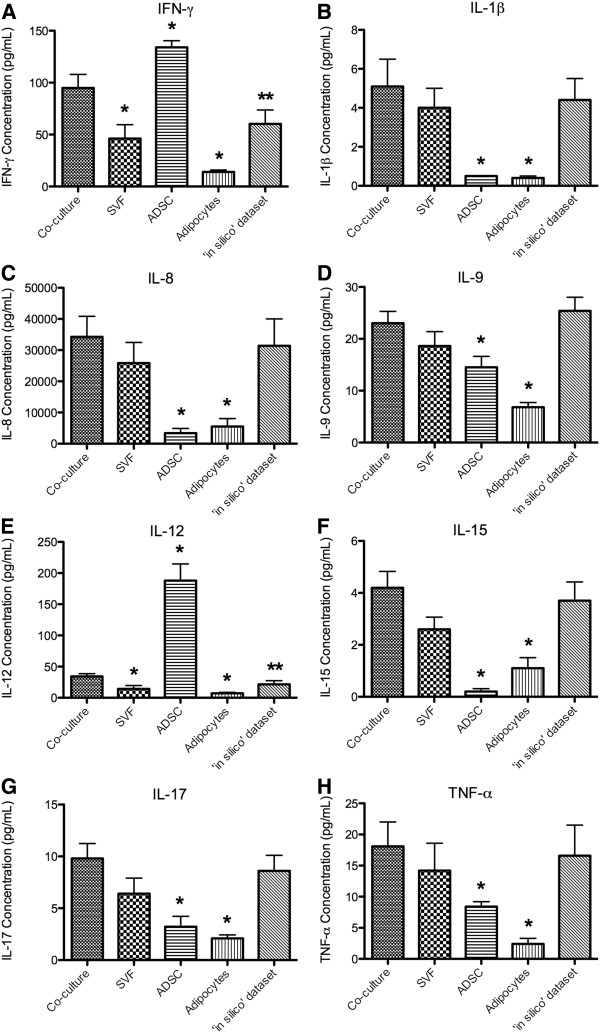
Average concentration of pro-inflammatory cytokines secreted by adipose-derived cell populations. The concentrations of the pro-inflammatory cytokines, IFN-γ (A), IL-1β (B), IL-8 (C), IL-9 (D), IL-12 (E), IL-15 (F), IL-17 (G) and TNF-α (H) were measured in the conditioned medium of the stromal vascular fraction (SVF) co-cultured with adipocytes (co-culture), SVF, adipose-derived stem cells (ADSC), and adipocytes, as well as the ‘in silico’ dataset. The reported values are the average of 5 biological replicate ± SEM. An * denotes a p-value of ≤ 0.05 and an ** denotes a p-value ≤ 0.1 when compared to the co-culture dataset.